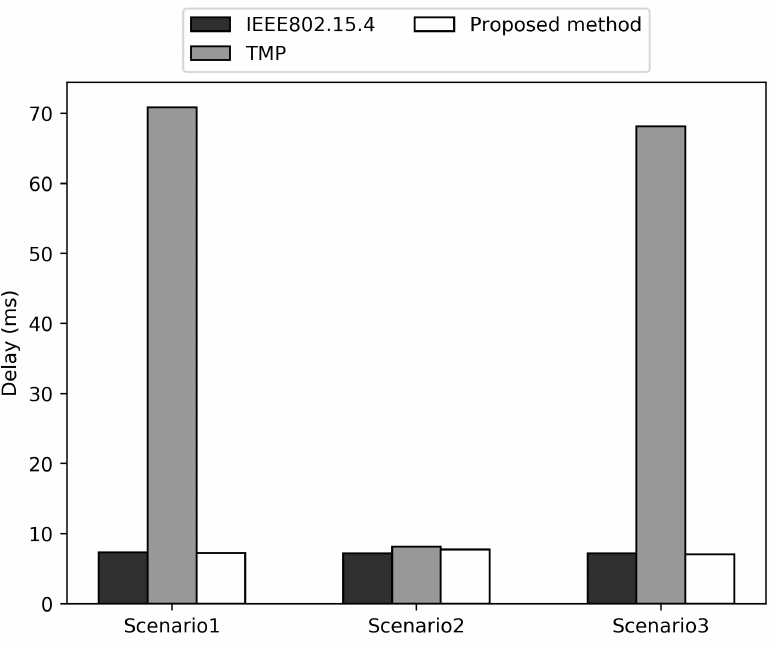
Figure 13. Delay of each scenario.